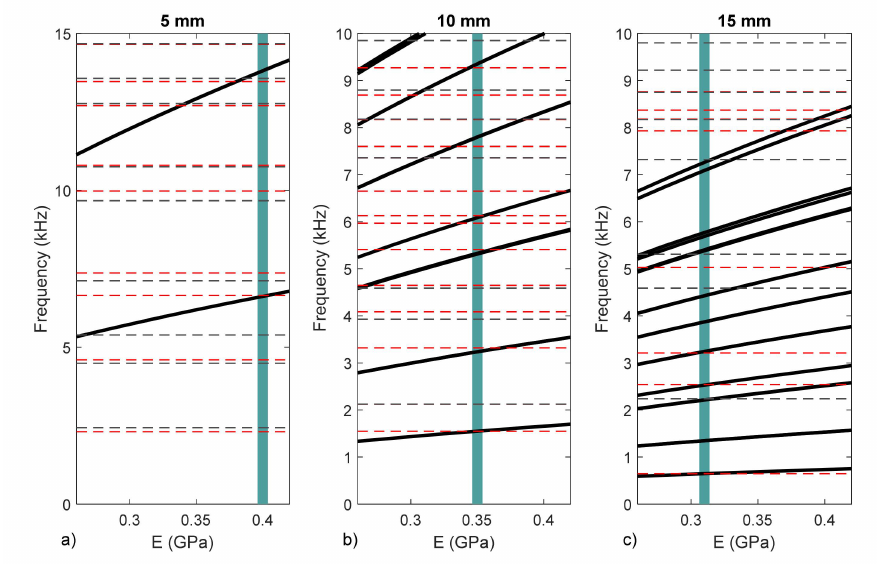
Figure 13. Young’s modulus determination for membranes with diameters of 5 mm ( a ), 10 mm ( b ), and 15 mm ( c